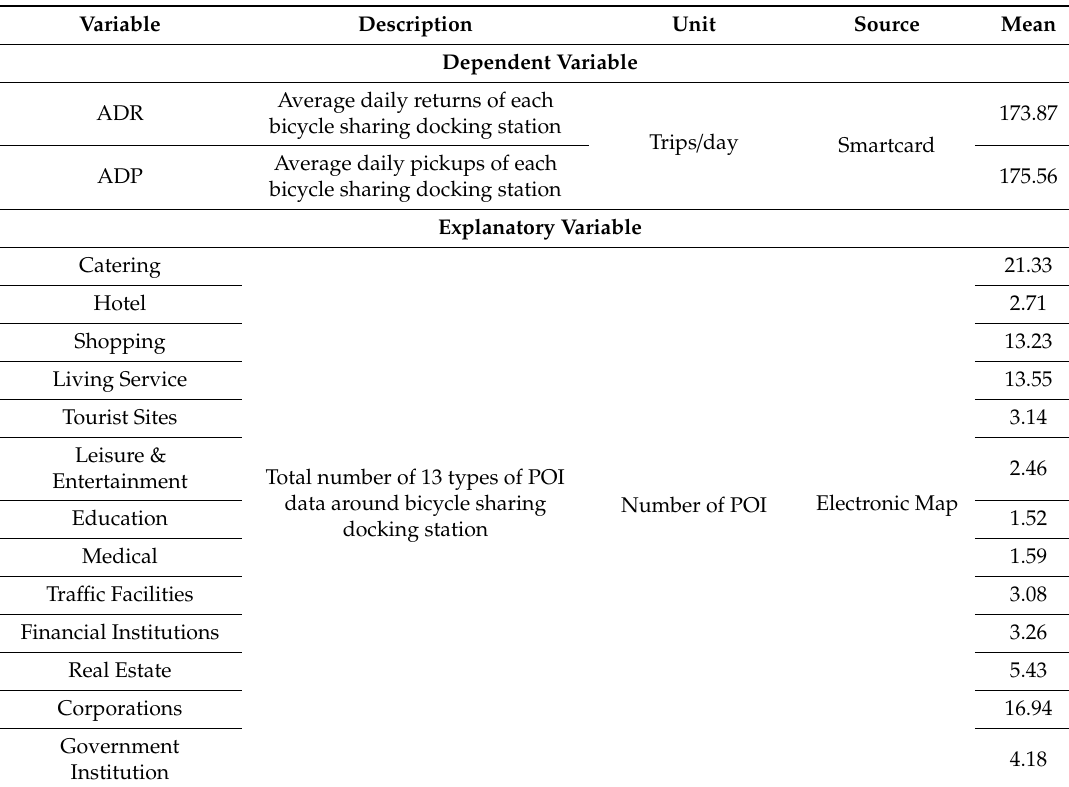
Table 1. Summary and descriptive statistics of variables of the GWR